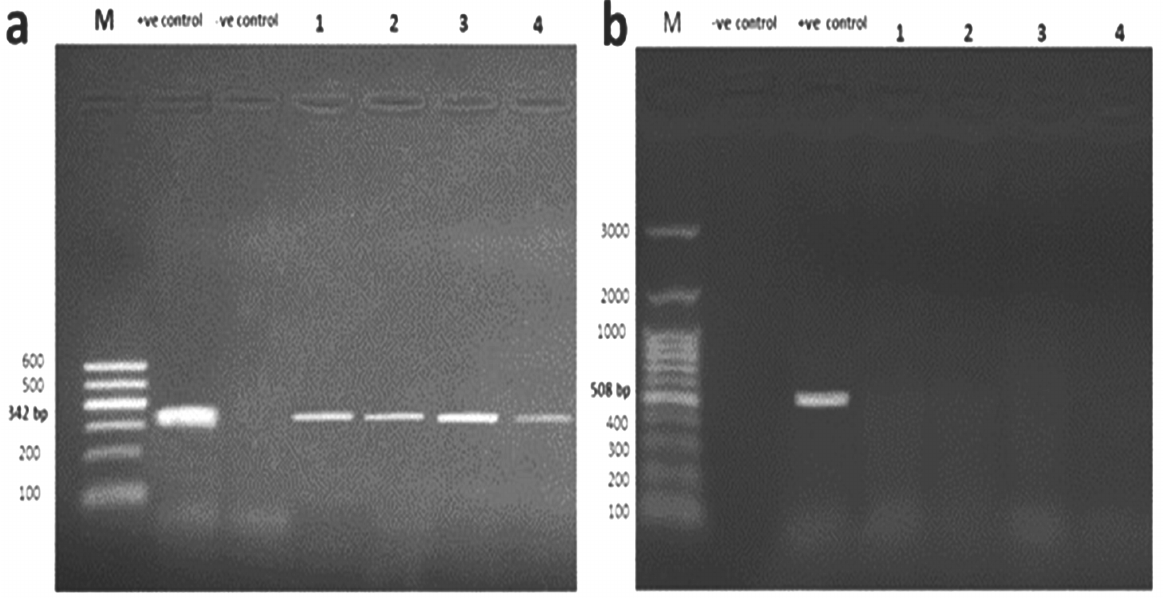
Figure 2. (a) PCR (4 pock lesion positive samples) analyses for EHV-1 using specific primers for partial sequences of gB gene. The amplification products for gB appeared at the expected molecular weights for EHV-1 at 342 bp. Lane M represents 100 bp DNA molecular weight ladder (ABgene). (b) PCR (4 pock lesion positive samples) analyses for EHV-4 using specific primers for partial sequences of gB gene showing negative results for EHV-4 at 508 bp. Lane M represents 100 bp DNA molecular weight ladder